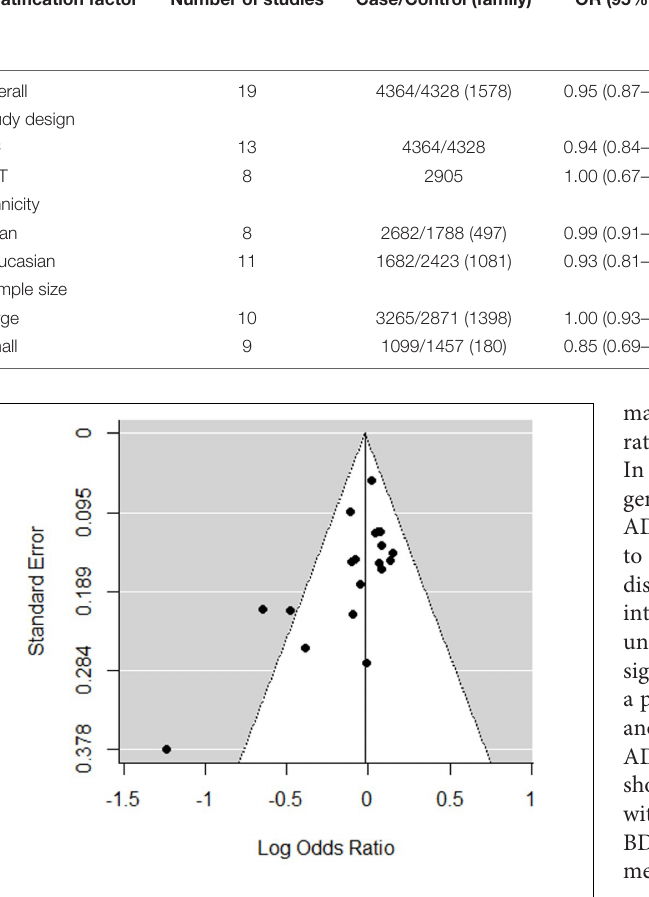
design, Asian and European populations, and large and small sample-size